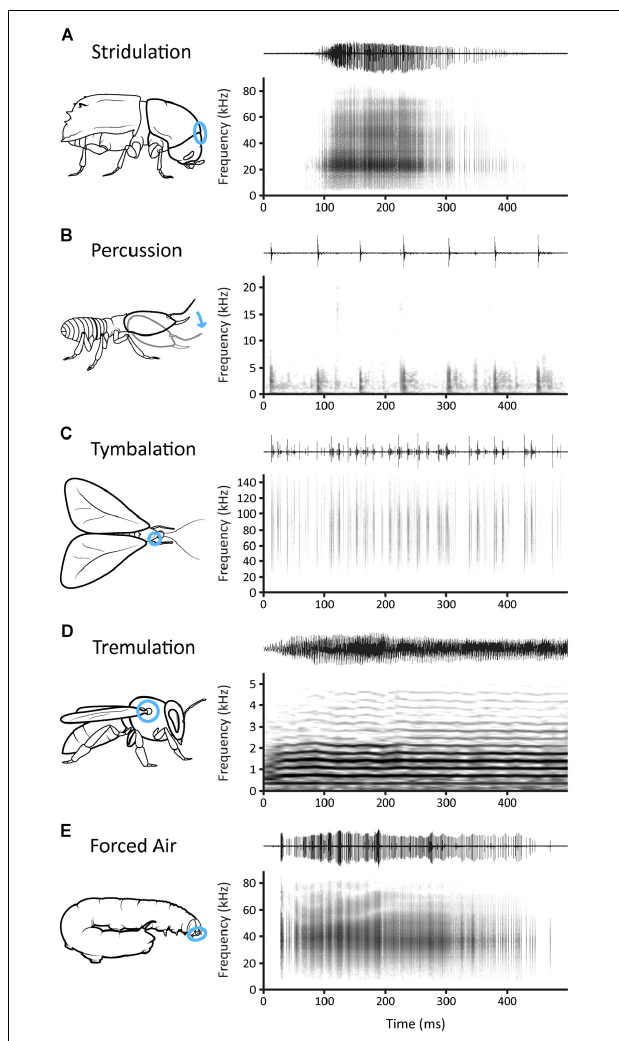
FIGURE 2 | The five types of mechanisms that insects use to produce defense sounds, illustrated by examples from five different insects. Blue circles correspond to the location of the mechanism in the chosen example. Waveforms and corresponding spectrograms show 500 ms of sound from each species. (A) Stridulation: a single chirp produced by an Ips pini bark beetle. Chirps are produced using a file and scraper mechanism located between the head and pronotum. (B) Percussion: a series of drumming signals by a Macrotermes natalensis termite. The signals are produced by tapping the substrate with its head. (C) Tymbalation: a series of clicks produced by a Eubaphe unicolor moth. Clicks are produced via a pair of tymbals located one on each side of the prothorax. (D) Tremulation: a group piping signal produced by Apis florea bees. Piping sounds are produced through vibrations of the flight muscles. (E) Forced Air: a single vocalization produced by an Amphion floridensis caterpillar. Vocalizations are made by airflow from the alimentary canal. Sound files were contributed by the Yack Lab ( I. pini and A. floridensis ), F. Hager ( M. natalensis ), A. Corcoran ( E. unicolor ), and S. Fuchs ( A. florea ). See text and Table 1 for further details on these examples.